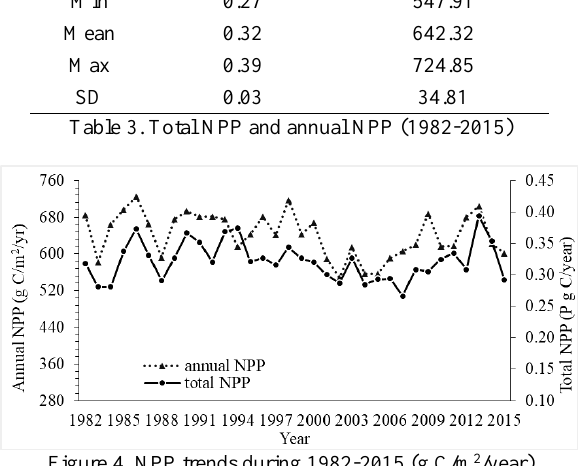
Figure 4. NPP trends during 1982-2015 (g C/m 2